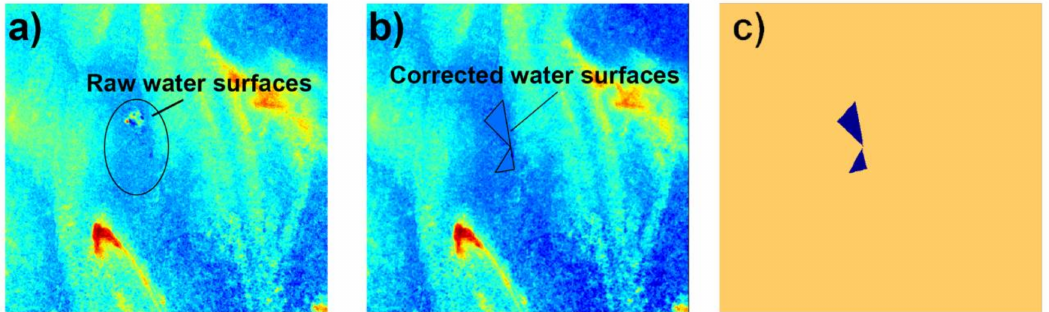
Figure A4. Example of processing applied to surfaces with water areas. ( a ) The raw DEM without any water surface treatment; ( b ) DEM with corrected water surfaces; ( c ) Surface nature as entered in CALM (water in blue, ground in